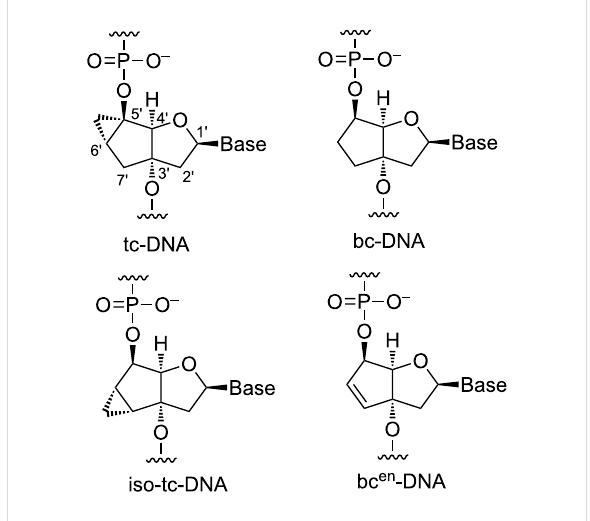
Figure 1: Chemical structures and carbon numbering scheme of tricyclo(tc)-DNA (top, left), bicyclo(bc)-DNA (top, right) and the newly synthesized iso-tricyclo(iso-tc)-DNA (bottom, left) and bicyclo-en(bc en )- DNA (bottom, right).